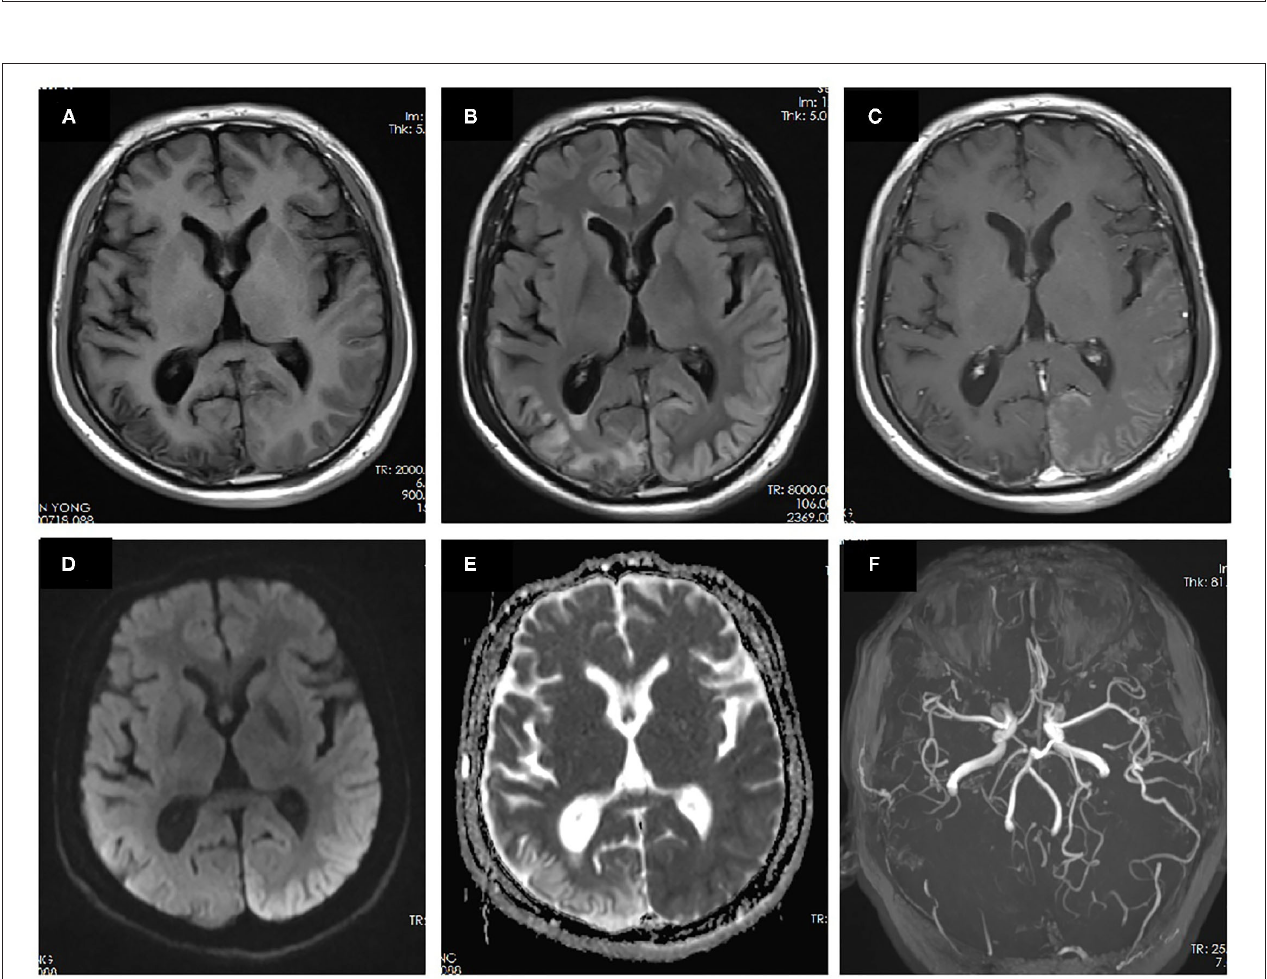
FIGURE 2 | MRI performed 10 days after onset of the second prolonged attack. Right temporal-occipital hyperintensity on T1-weighted images (A) with gliosis on T2-FLAIR images (B) suggests the chronic stage of cortical necrosis caused by first prolonged attack. Left temporal–occipital cortex hyperintensity on T2-FLAIR images (B) with gyriform enhancement (C) , restricted diffusion (D) , and normal apparent diffusion coefficient (ADC) (E) suggests the subacute stage of cortical necrosis caused by second prolonged attack. MRA demonstrated vasodilation of the branches of the left middle cerebral artery (MCA) and posterior cerebral artery (PCA) (F) .